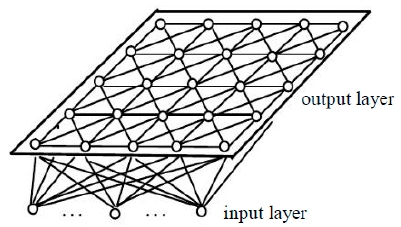
Figure 2. Topology of self-organizing map network.